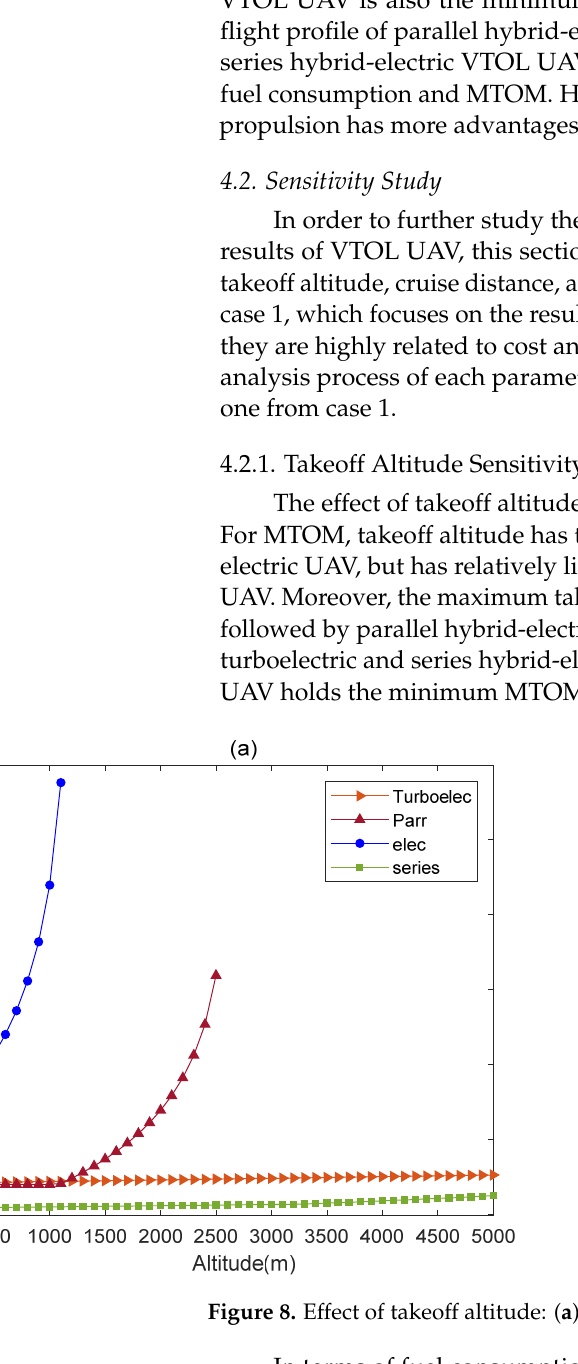
Figure 9. Effect of cruise distance: ( a ) MTOM; ( b ) fuel consumption.